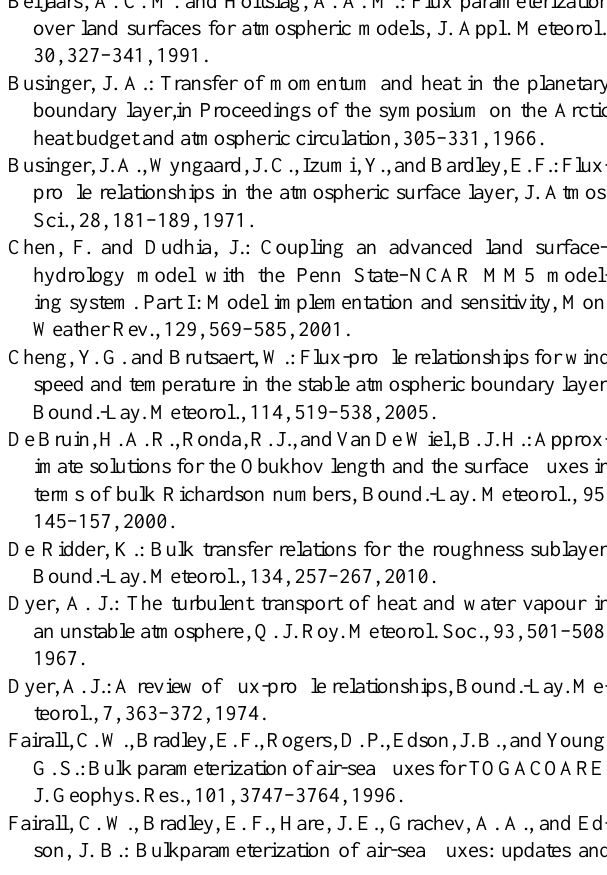
accuracy and computational